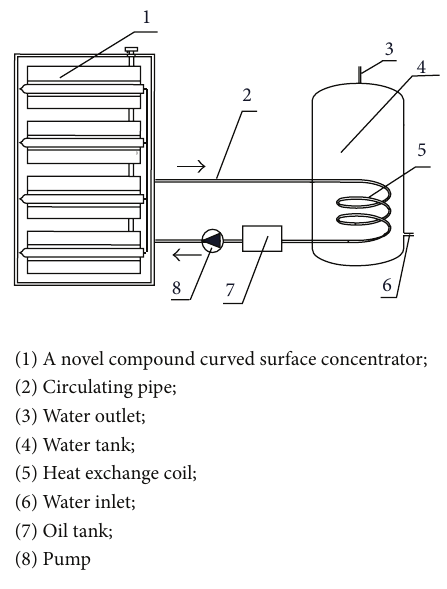
Figure 8: Schematic experimental system for testing the prototype shell-encapsulated solar collector.